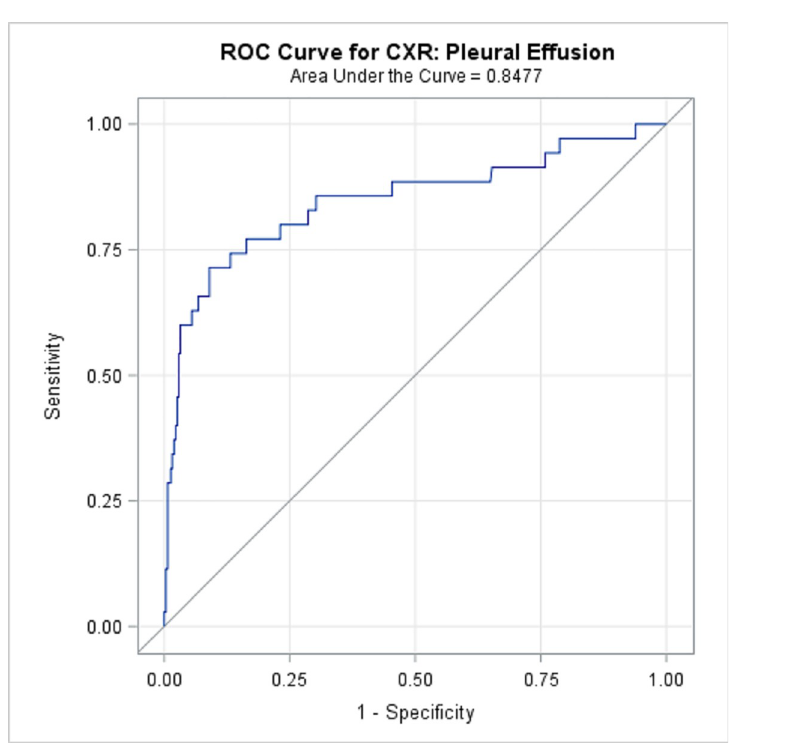
Fig 4. ROC Curve for CXR: Pleural Effusion.